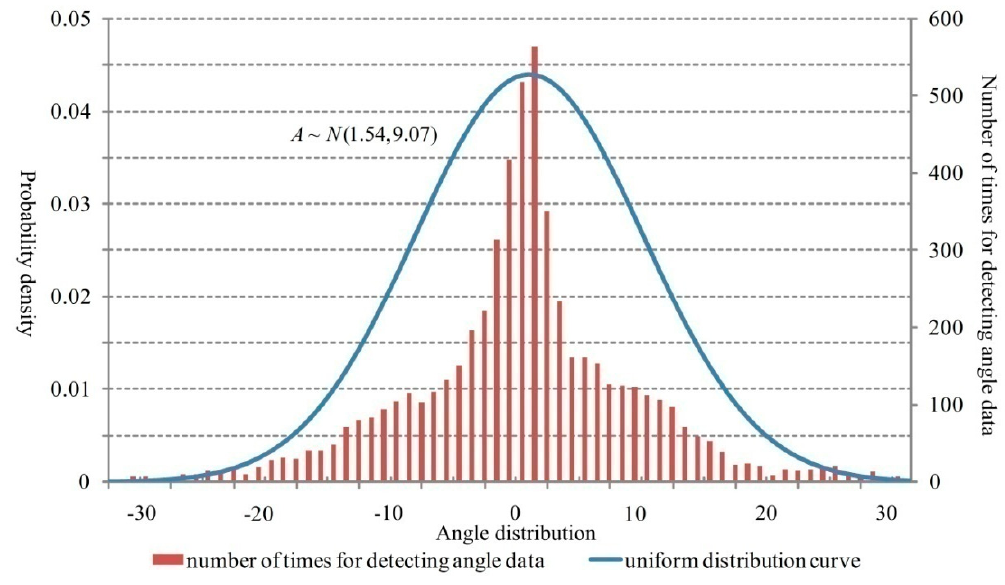
Figure 7. Distribution of the frequency for angle measurement.